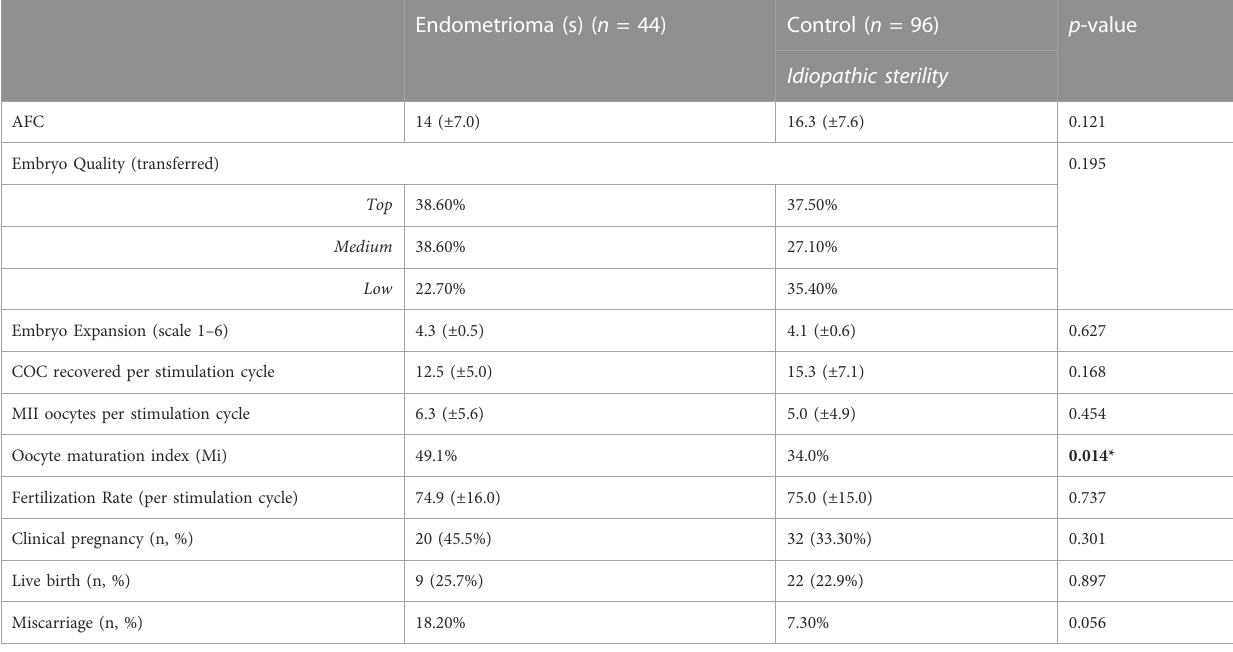
TABLE 4 Treatment cycle primary and secondary outcomes in subgroup analysis of endometriosis patients after endometrioma